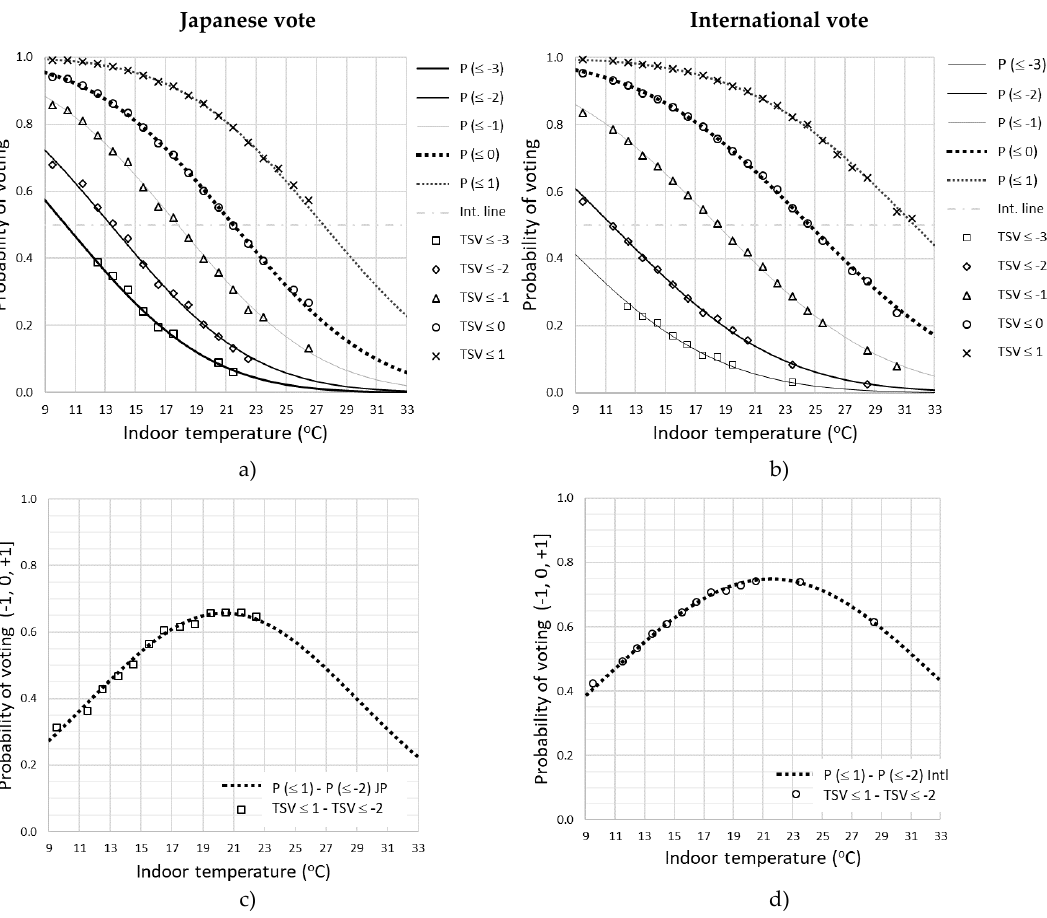
Figure 12. Graphical representation of probit analysis: ( a ) Probability of voting a certain TSV for Japanese subjects; ( b ) probability of voting a certain TSV for international subjects; ( c ) probability of voting within the “extended neutral range” of TSV scale—from − 1 to +1 for Japanese subjects; ( d ) probability of voting within the “extended neutral range” of TSV scale—from − 1 to +1 for international subjects. Note: Marker points represent the actual proportion of voting.